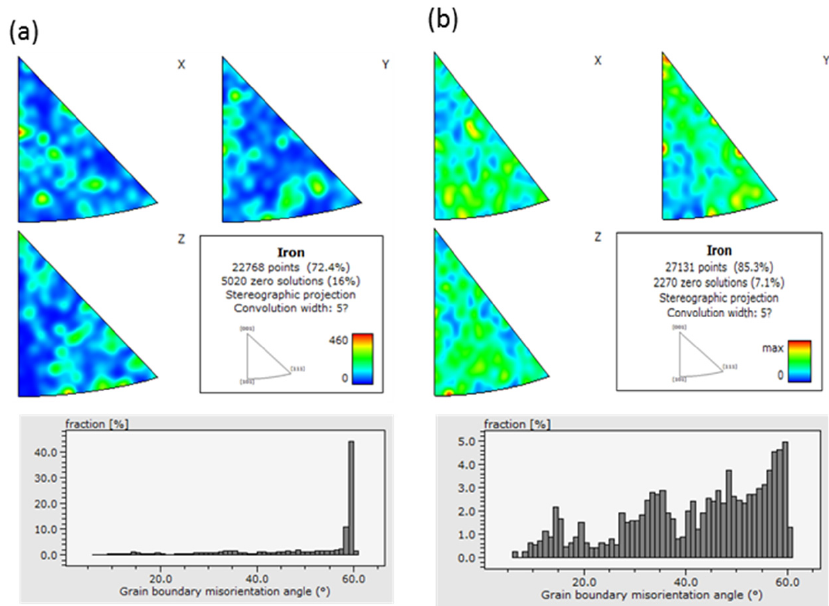
Figure 3. Reverse pole diagram and grain boundary orientation angle diagram of a 316L stainless steel sample before and after laser shock treatment: ( a ) untreated and ( b ) after one laser shock treatment.